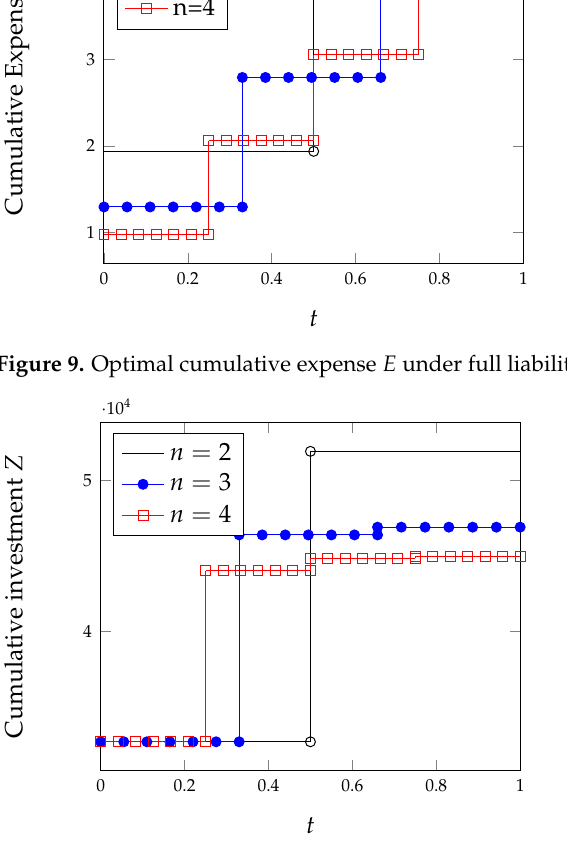
Figure 10. Optimal cumulative investment under partial liability and GL2